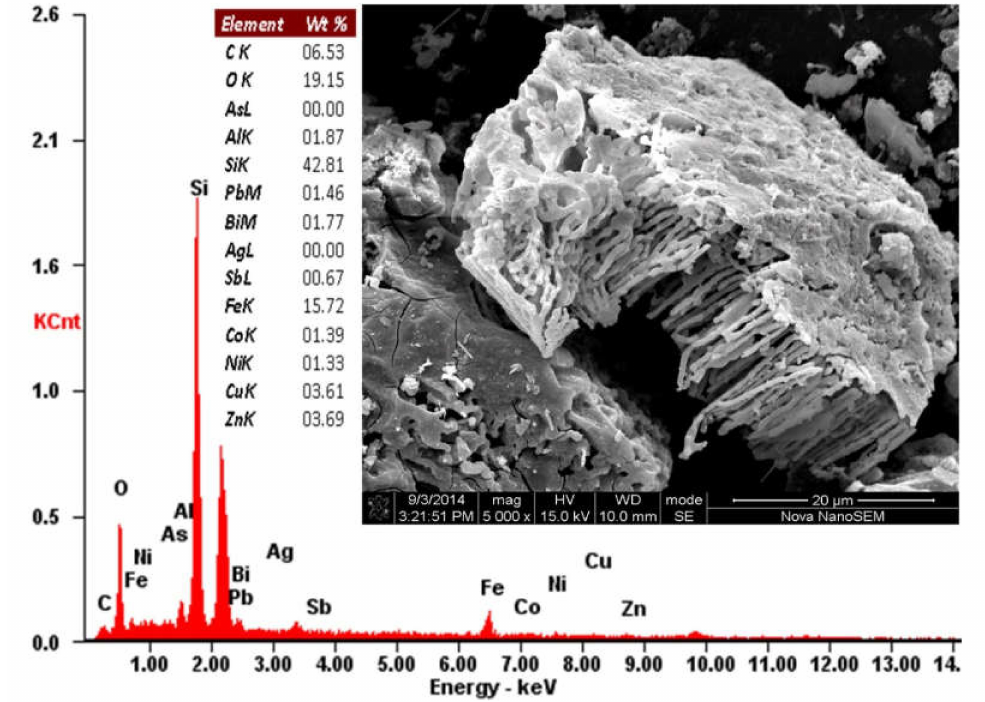
Figure 15. Scanning electron microscope–X-ray energy dispersive (SEM-EDAX) characterization of converter slag after leaching of Cu, Ni, Co, and Fe using 2 N citric